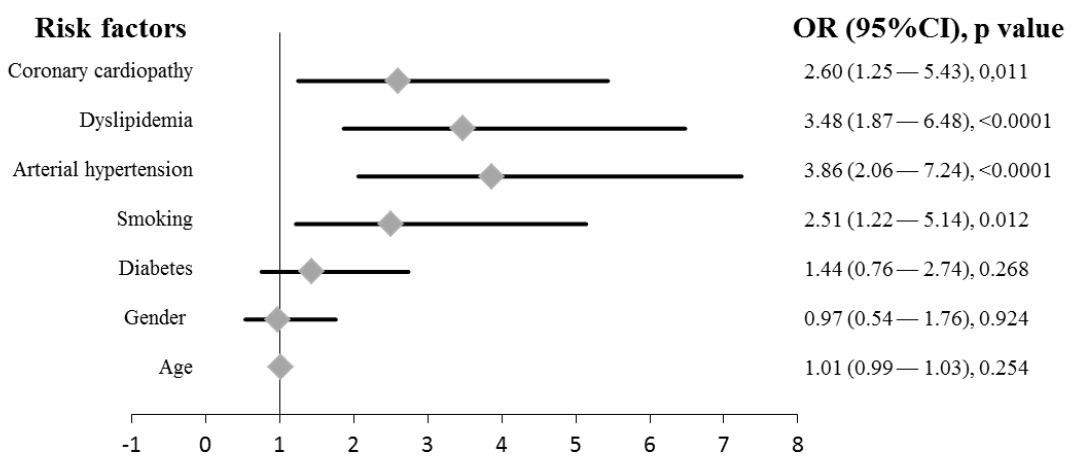
Figure 1. Forrest plot of odds ratios (ORs) with 95% confidence interval (CI) for factors associated with stroke. Each diamond represents the OR and the horizontal line indicates the 95% CI. For the binary logistic regression, patients were dichotomized into two groups as follows: patients who suffered stroke vs. patients who did not suffer the disease.